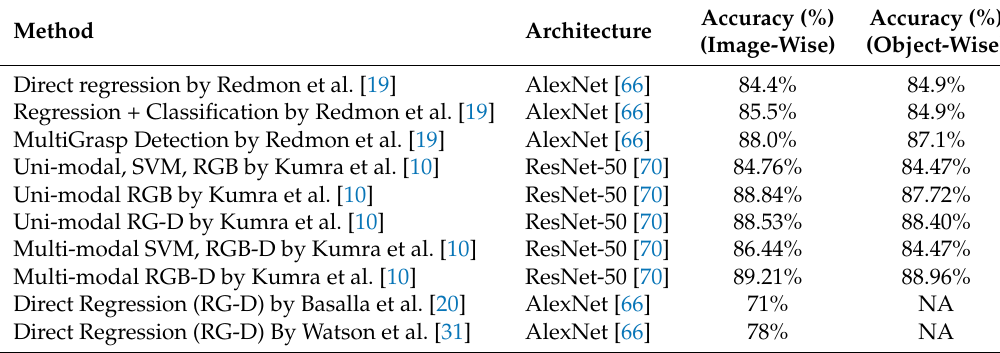
Table 2. Comparison between different transfer learning techniques in one-shot grasp detection. Results were reported from tests performed on the Cornell Grasp